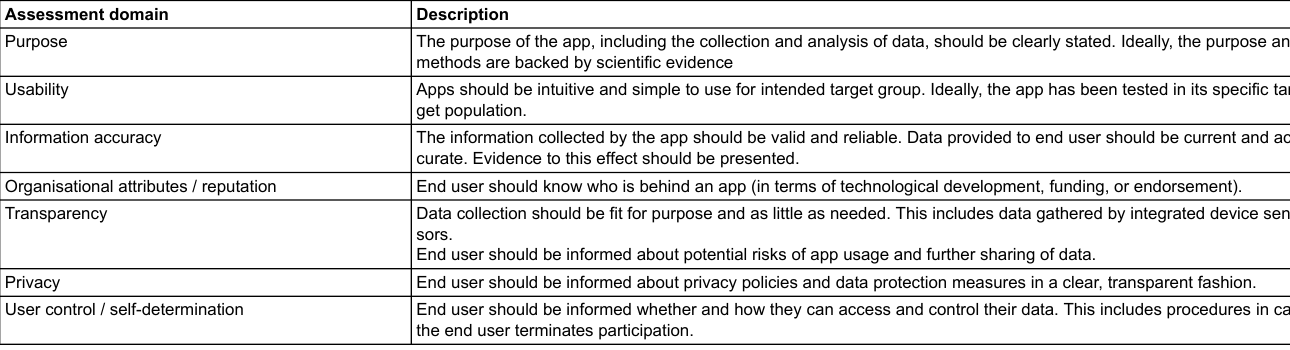
Table 3: Domains included in assessment